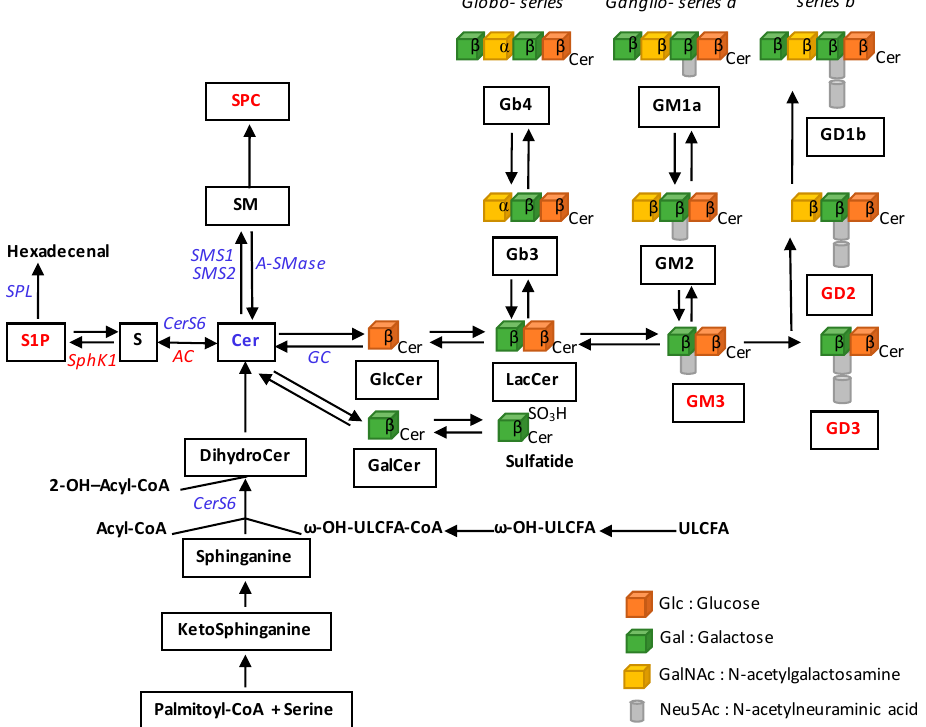
Figure 3. Multiple dysregulations of sphingolipid metabolism in melanoma. SL metabolites or SL-metabolising enzymes whose levels or expression are altered in melanoma, are mentioned. Decreases are indicated in blue and increases in red. AC, acid ceramidase; Cer, ceramide; CERS, ceramide synthase; CoA, coenzyme A; DihydroCer, dihydroceramide; GalCer, galactosylceramide; GC, glucosylceramidase; GlcCer, glucosylceramide; LacCer, lactosylceramide; S, sphingosine; S1P, sphingosine 1-phosphate; SM, sphingomyelin; SMases, sphingomyelinases; SMS, sphingomyelin synthase; SPC, sphingosylphosphorylcholine; SphK, sphingosine kinase; SPL, S1P lyase; ULCFA, ultralong chain fatty